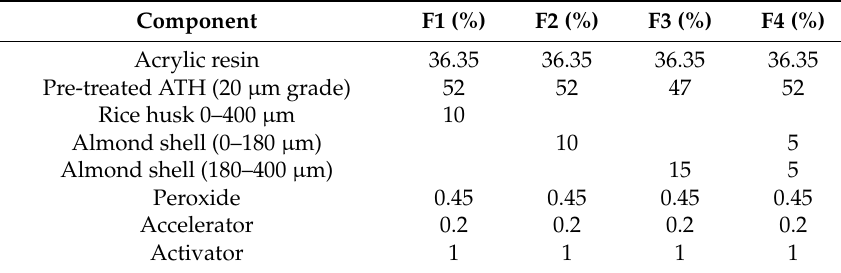
Table 2. Composition of the four material formulations